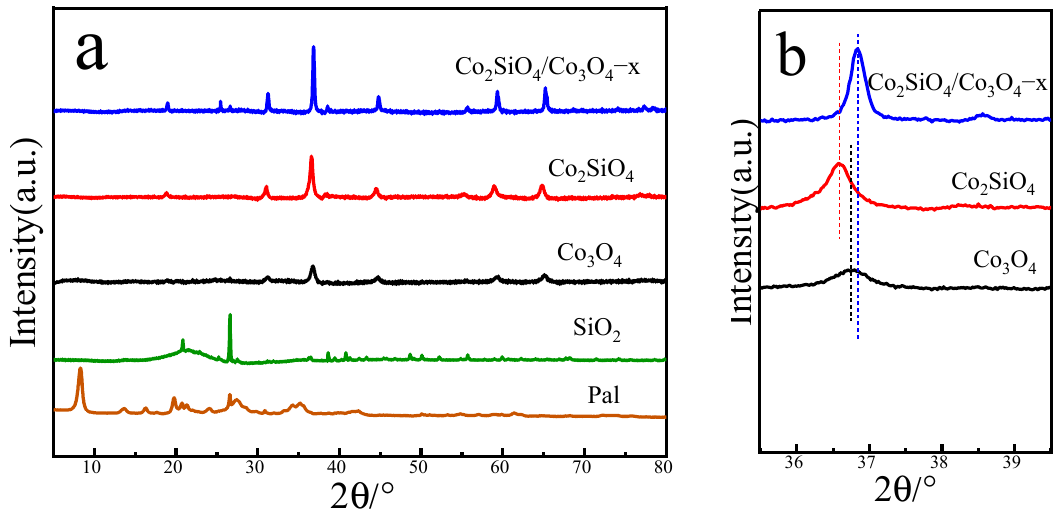
Figure 1. ( a ) XRD spectra of Pal, SiO 2, Co 3 O 4 , Co 2 SiO 4 , and Co 2 SiO 4 /Co 3 O 4 − x; ( b ) enlarged XRD patterns in a 2 θ range of 36.5° − 39.5°.